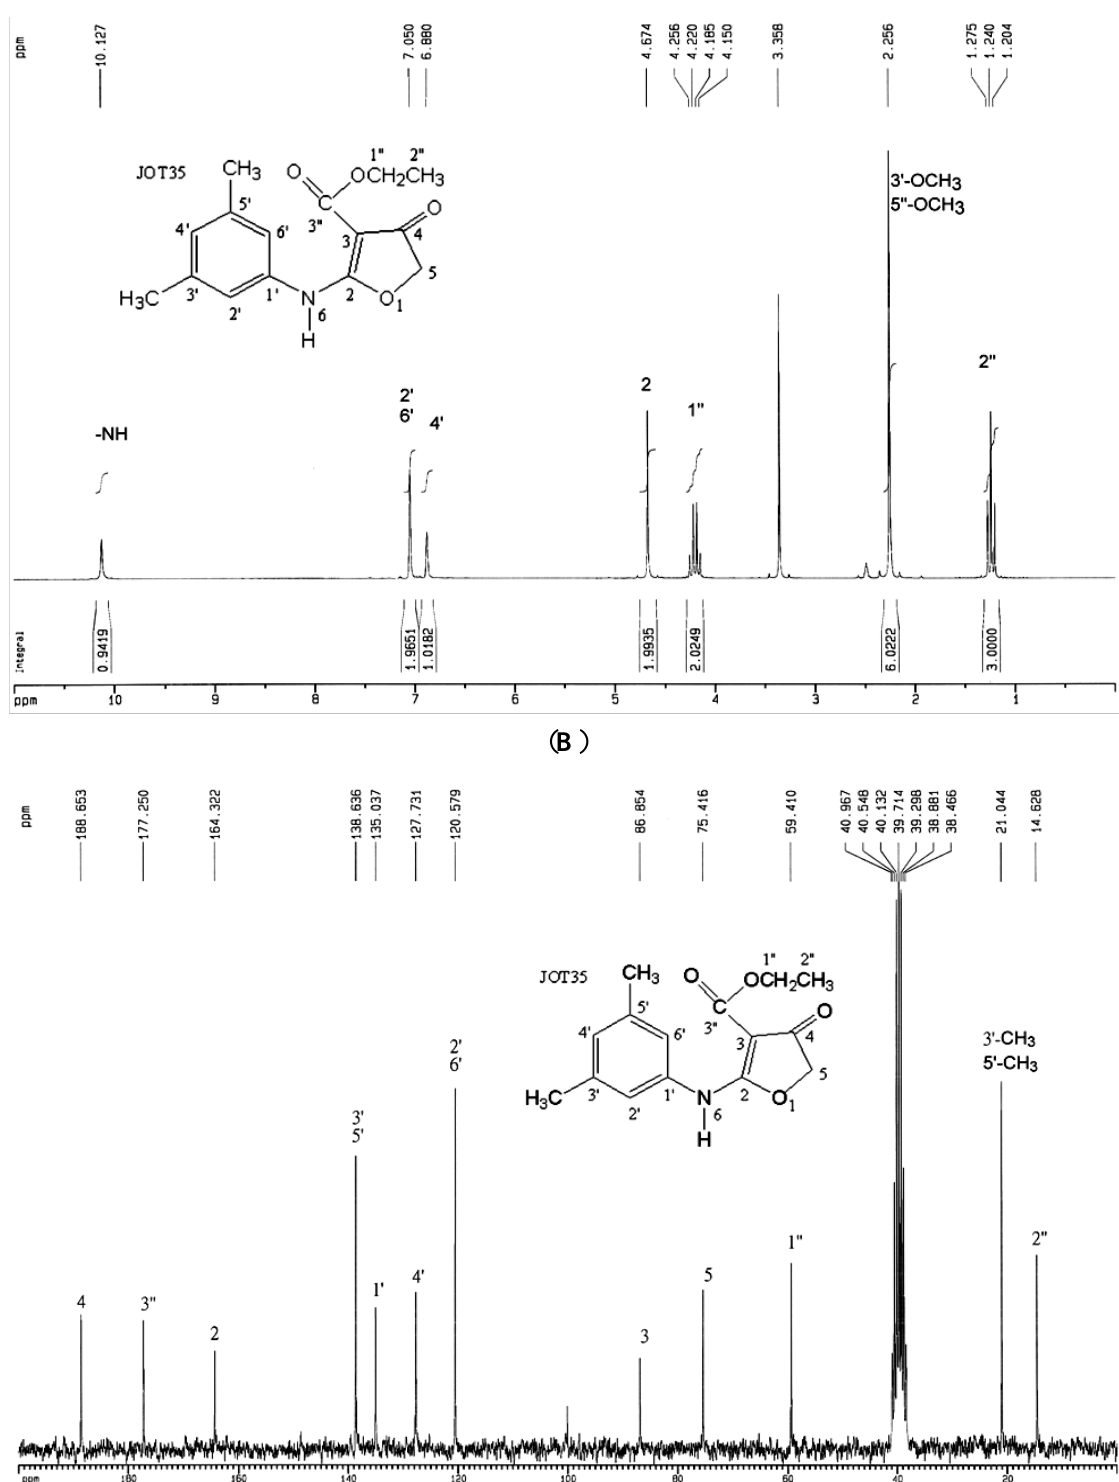
Figure 1. CW-33 chemical synthesis and NMR characterization (Ethyl 2-(3′,5′-dimethylanilino)-4-oxo-4,5-dihydrofuran-3-carboxylate). Flow diagram of CW-33 synthesis appears in ( A ). 1 H-NMR and 13 C-NMR spectra of CW-33 are shown in ( B , C ), respectively.